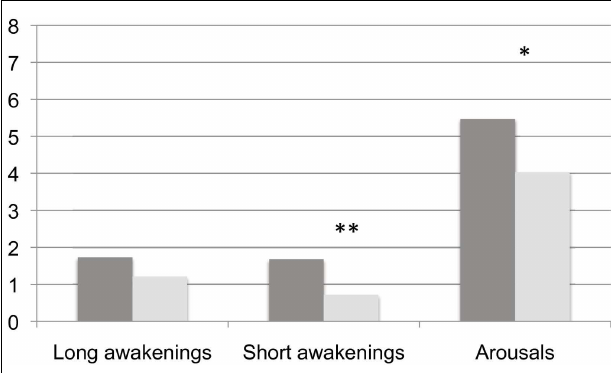
FIGURE 2 | Frequency of behavioral awakenings and arousals in the two experimental conditions. Dark gray columns: BL, light gray columns: TR Frequencies of awakenings and arousals are calculated over hours of AST. *, ≤ 0.05 and **, ≤ 0.01.